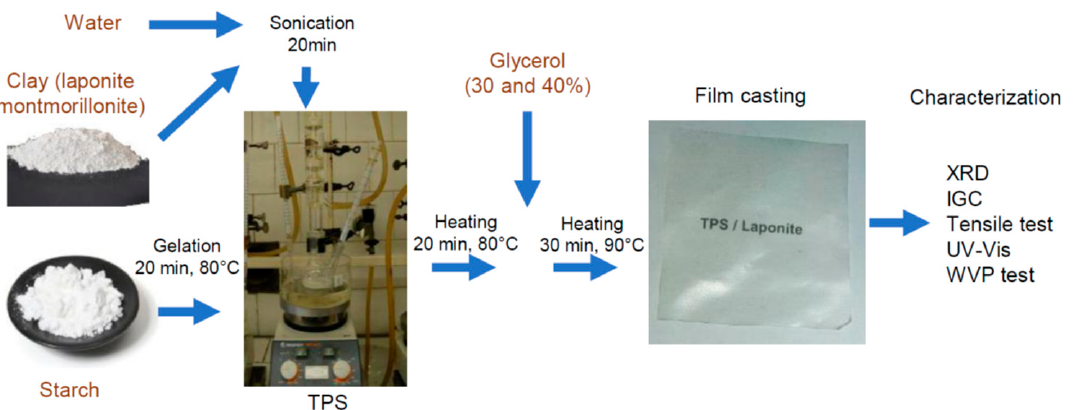
Figure 1. Treatments applied to prepare TPS/nanoclay films from starch powder and montmorillonite/laponite. A schematic representation of the multi ‐ step process.